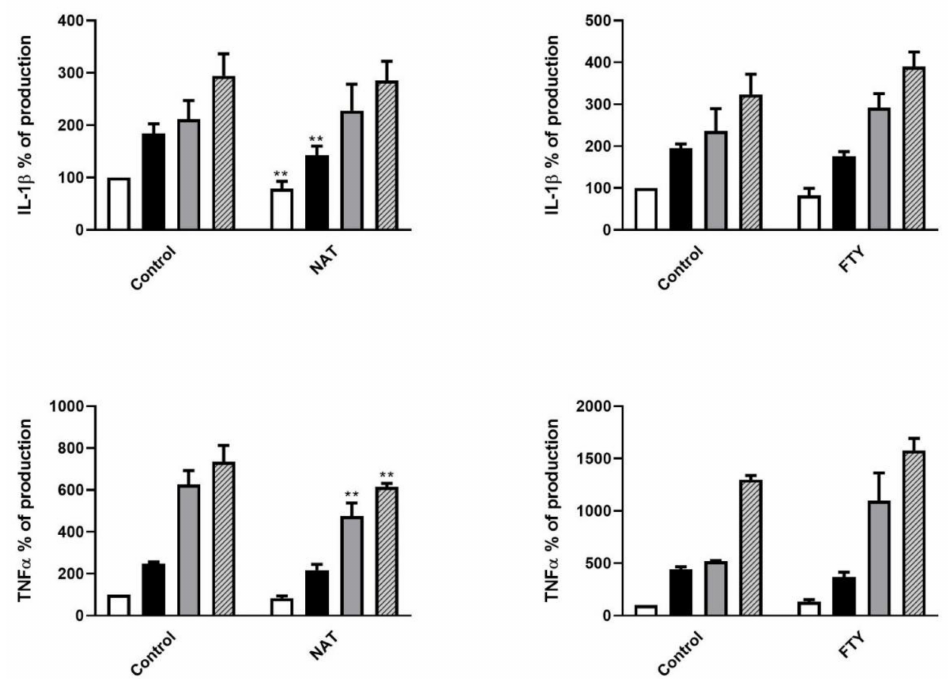
Figure 6. Second-line DMTs reduced cytokine release by PMNs stimulated with K. pneumoniae. Supernatants of pretreated PMN with NAT (left panel) or FTY (right panel), stimulated with K. pneumoniae (ratio 10:1) for 30, 60, 90 and 180 min, were assayed to evaluate CXCL8, IL-1 β and TNF- α production. Data are shown as mean ± SEM from at least three independent experiments. ** p < 0.05 vs. untreated cells following K. pneumoniae challenge, by using the unpaired T-test. Results from unpretreated cells following K. pneumoniae stimulation at T30 are set as